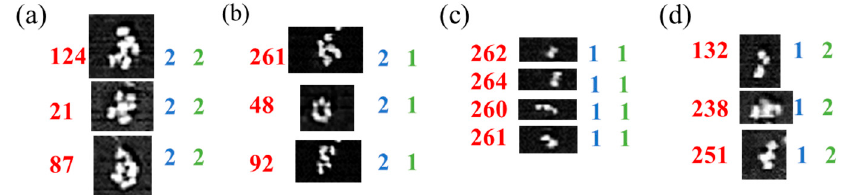
Figure 10. Cotton seedling images. The red numbers are the IDs of the ROI. Blue numbers are the manual count and green numbers are the estimated number of seedlings in the ROIs. ( a ) and ( c ) are the correct estimation of two and one seedlings respectively. ( b ) and ( d ) are the incorrect estimation of two and one seedlings respectively.